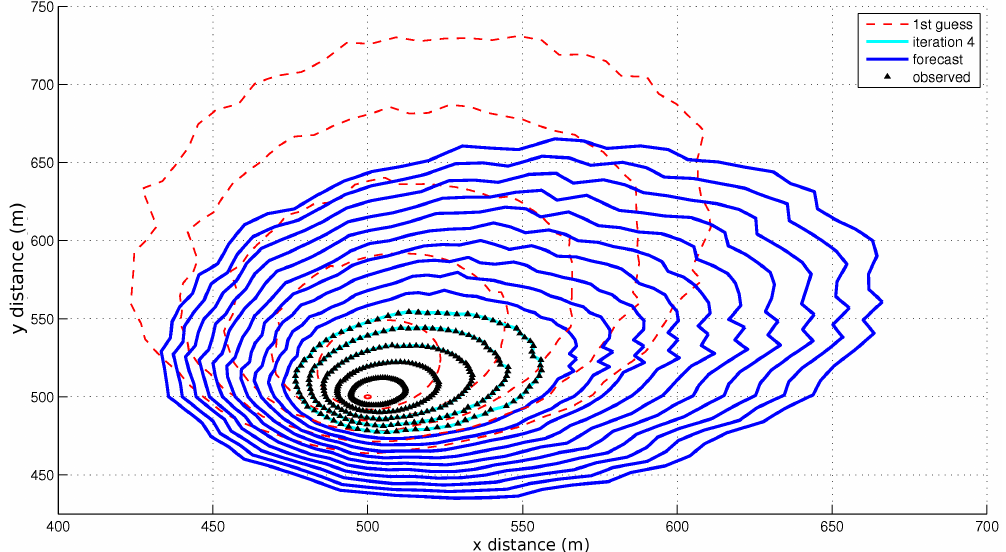
Figure 8. Five assimilated fire fronts with 1min intervals (black solid lines). The first guess (red dashed line) is taken to be far from the true invariants vector to check the algorithm capability to converge. A 10min forecast (blue solid lines) is also calculated using fuel depth as sensor